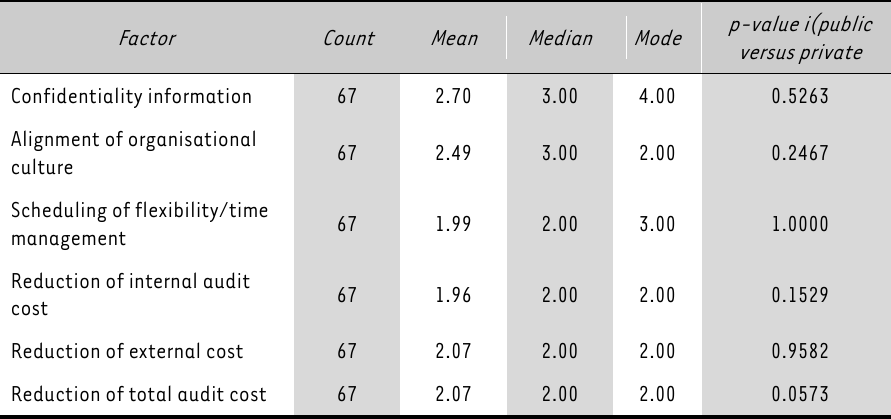
p-value i(public versus private